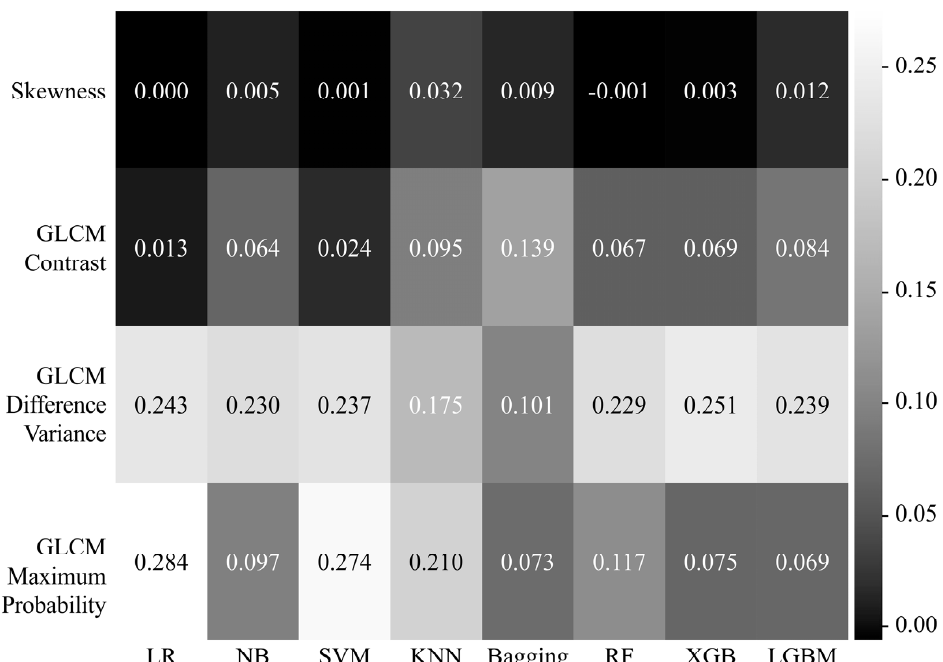
Figure 5. Heatmap showing the effect of the four features on the training of each machine learning model. The higher the heatmap value and the closer to white, the stronger the influence of the feature on the differentiation between COVID-19 and pneumonia. GLCM, gray level co-occurrence matrix; LR, logistic regression; NB, naive Bayes; SVM, support vector machine; KNN, k-nearest neighbor; RF,